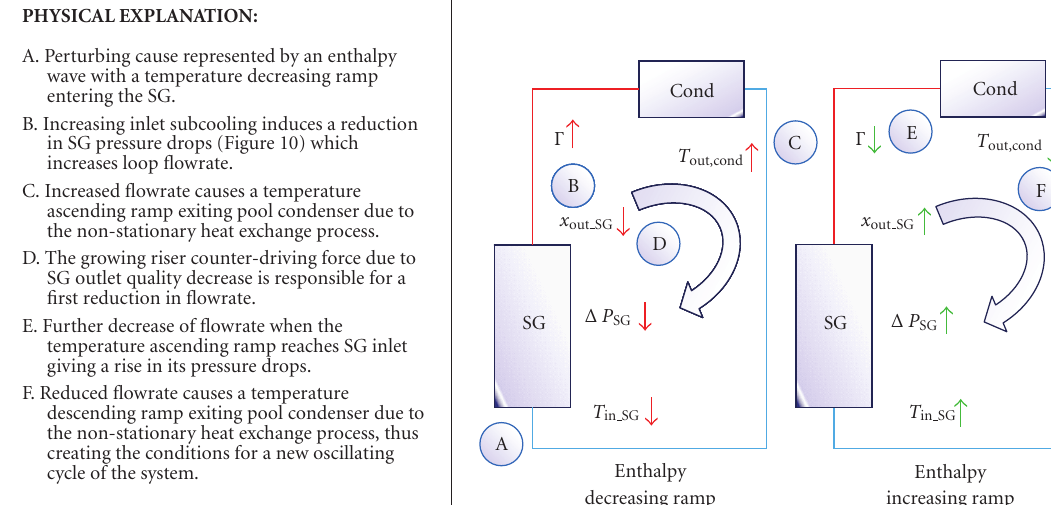
Figure 11: Schematic description of the physics involved in the low-frequency